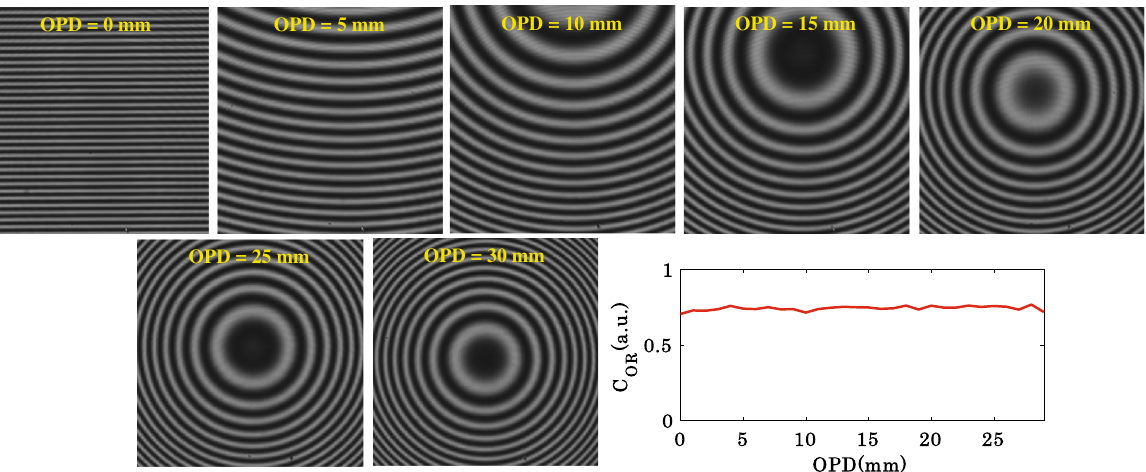
Figure 6. The interferograms generated due to the superposition of correlated speckle fields in both the object and the reference arms of the interferometer as a function of the optical path difference tems. The non-zero OPD only generates curved or circular fringes at the camera as illustrated in Fig. 6. The line profile illustrates the variation of the normalized correlation between the object and the reference speckle fields as a function OPD. It can be seen that the correlation does not drop between the speckle fields as a function of increased OPD. This is due to the high temporal coherence length and double pass of the speckle field through the same objective lens in the reference arm, which keeps the speckle fields correlated with the object arm speckle field. The double pass through the objective lens cancels the effect of non-zero OPD on the speckle field and keeps the speckle size and shape unchanged in the reference arm. The correlation values between the object and the reference speckle fields as a function of OPD are given in the Supplementary Table S1. Phase imaging with scalable FOV and resolution. In the previous section, it has been successfully demonstrated that different magnification and numerical aperture objective lenses can used in the object arm of the IM system without affecting the quality of the resultant interference pattern. The fringe density of the inter- ference pattern is kept less to clearly show the potential of the DSI in IM system. However, this is not only limited to low fringe density of the interference pattern. The fringe density can be made very high to implement single shot IM. The fringe density can be increased by tilting the reference mirror. The tilting of the mirror decorrelates the object and reference speckle fields, which can be adjusted by translating the mirror either towards or away from MO 1 . The high fringe density interferogram of the USAF chart and its single shot recovered phase map is illustrated in Supplementary Fig. S8. To demonstrate the capability of DSI in terms of enabling scalable FOV and resolution possibility in IM, experiments are conducted on USAF resolution test target (Thorlabs: part # R3L3S1N) and placenta tissue sample. The placenta tissue sample is sectioned into 1 μm thick cryosection (EMUC6 ultramicrotome, Leica Microsystems, Vienna, Austria), and placed on top of a reflecting Si substrate. The sample is placed inside a polydimethylsiloxane (PDMS) chamber of thickness of 500 μm and opening size of 5 mm × 5 mm as illustrated in the experimental setup (Fig. 8). Thereafter, 50 μl volume of phosphate-buffered saline (PBS) is put inside the PDMS chamber to keep the tissue sample hydrated and sealed with a cover glass of # 1.5 to enable the use of objective lenses for imaging. The details of the tissue sample preparation can be found in Ref. 17 . The Regional Committee for Medical and Health Research Ethics of Norway (REK_nord) approved the ethical clearance and informed consent was obtained from all participants for conducting the experiments on the tissue samples and all methods were performed in accordance with the relevant guidelines and regulations. For USAF chart, experiments are performed using 10 ×/0.25NA, 20 ×/0.45NA and 60 ×/0.7NA objective lenses in the object arm keeping 10 ×/0.25NA objective lens in the reference arm. Similarly, for placenta tissues samples, interferometric data is recorded with only two objective lenses 10 ×/0.25NA and 20 ×/0.45NA to exhibit large FOV imaging. For both the sample, random phase shifted interferograms are recorded and then PCA based reconstruction algorithm is implemented for their phase recovery 28 . The phase shift between the interferograms is introduced by shifting the reference mirror using piezo transducer with nanometer precision. Figure 7a–c illustrate the recovered phase maps of the resolution chart corresponding to 10 ×/0.25NA, 20 ×/0.45NA and 60 ×/0.7NA objective lenses, respectively. It can be seen that the recovered phase maps suffer from slowly vary- ing background phase due to the presence of minute optical aberrations in the IM system. This can be corrected numerically by employing any phase aberration compensation algorithm. The red dotted boxes in Fig. 7a,b illustrate the FOVs of 20 ×/0.45NA and 60 ×/0.7NA objective lenses, respectively. The recovered phase images of placenta tissue samples corresponding to 10 ×/0.25NA and 20 ×/0.45NA objec- tive lenses are exhibited in Fig. 7d,f, respectively. The zoomed views of the regions marked with yellow dotted boxes are illustrated in Fig. 7e,g. It can be clearly visualized that 20 ×/0.45NA generates higher resolution phase image of the sample compared to 10 ×/0.25NA. It can be visualized that the recovered phase maps do not suffer from the speckle noise and coherent noise. The stripe patterns observed in Fig. 7e,g are caused by the microtome